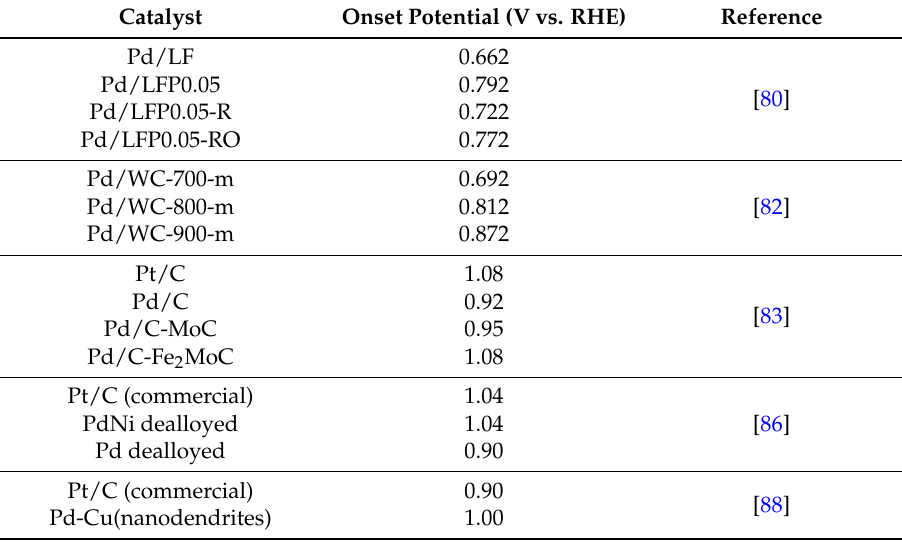
Table 7. Onset potential values for the ORR performed on non-carbon-supported Pd-based catalysts.